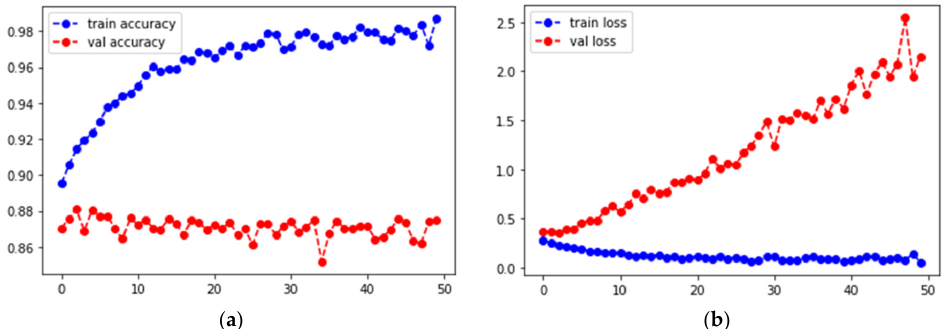
Figure 15. Training and testing of CNN + HPO model: ( a ) training and validation accuracy, ( b )